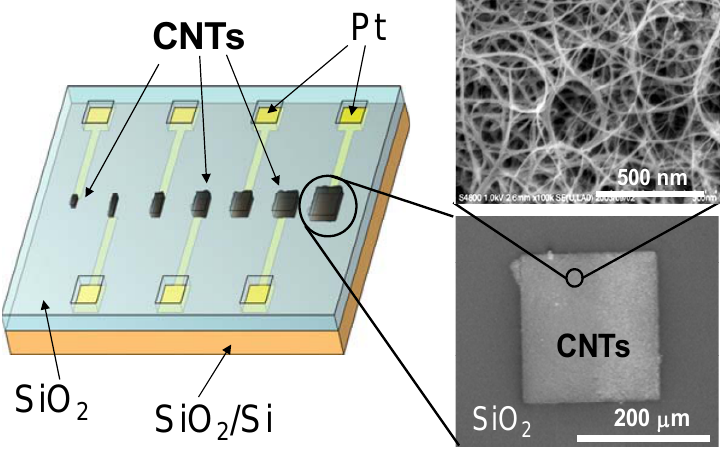
Figure 1. Schematic illustration of the CNT-arrayed electrodes. Inset: a scanning electron microscope (SEM) image of a CNT